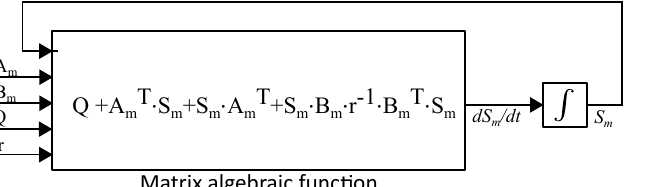
Figure 8. Block diagram used to calculate the numerical solution of the Riccati differential equation.